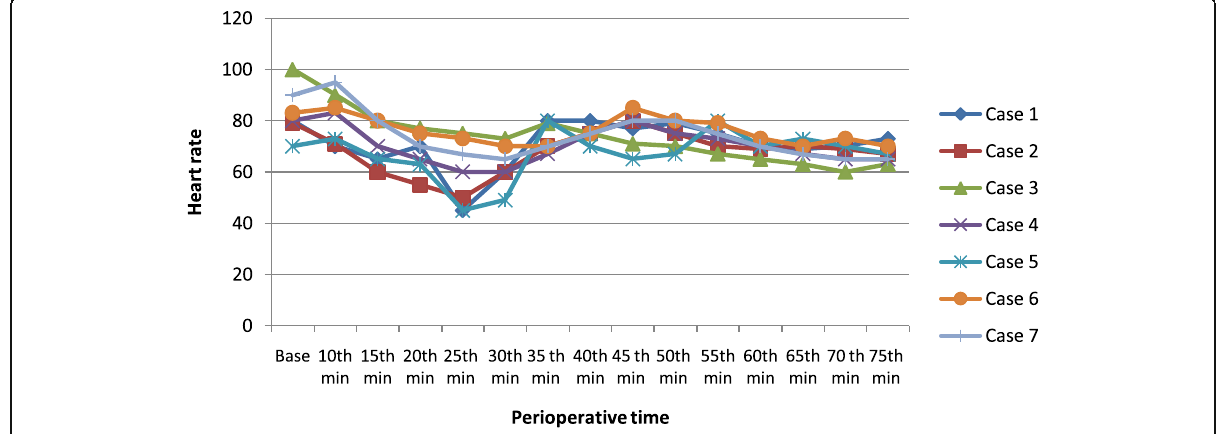
Fig. 2 Changes in heart rate in cases by the operation